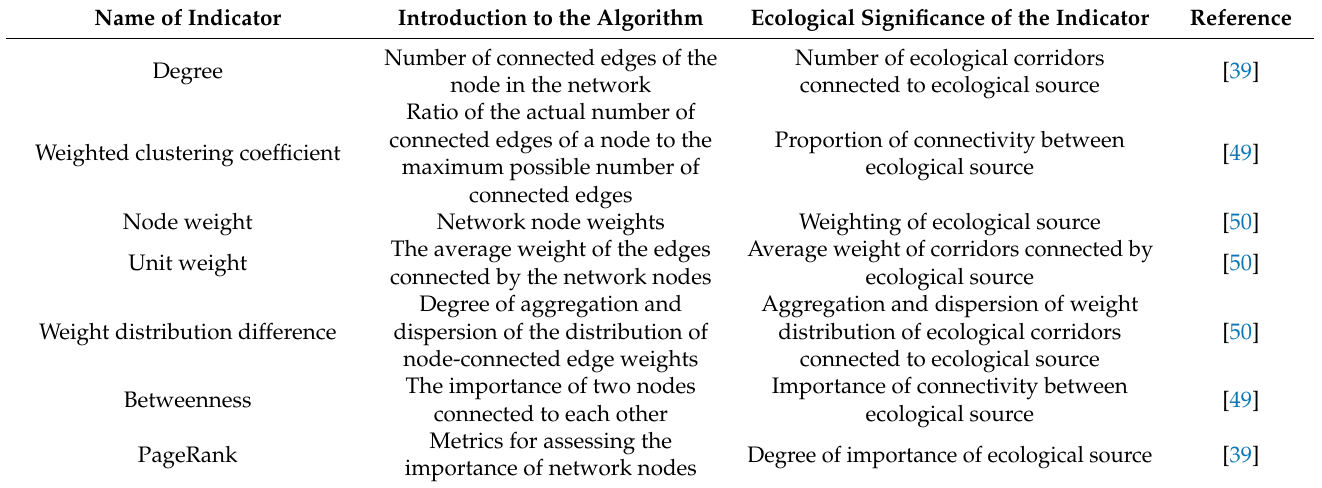
Table 3. Description of the topological